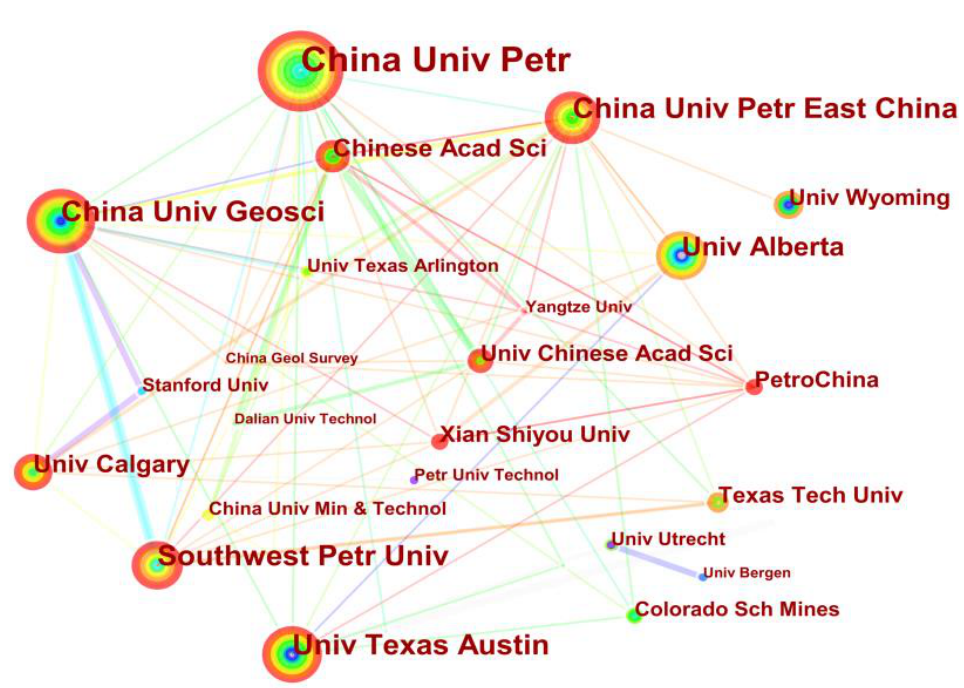
Figure 12. Journal co-citation network. Table 3. Top 10 journals by the number of publications.